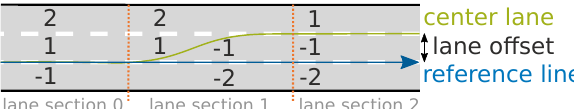
Figure 9. Lane offset functions used to laterally shift the center lane away from the road reference line.